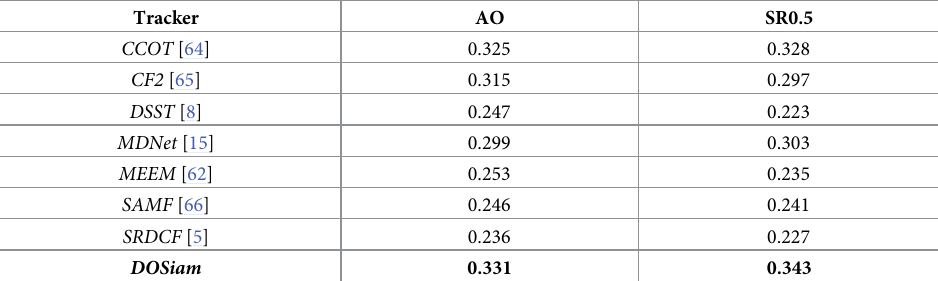
Table 6. Comparison with state-of-the-art trackers on GOT-10k in terms of AO and SR0.5.